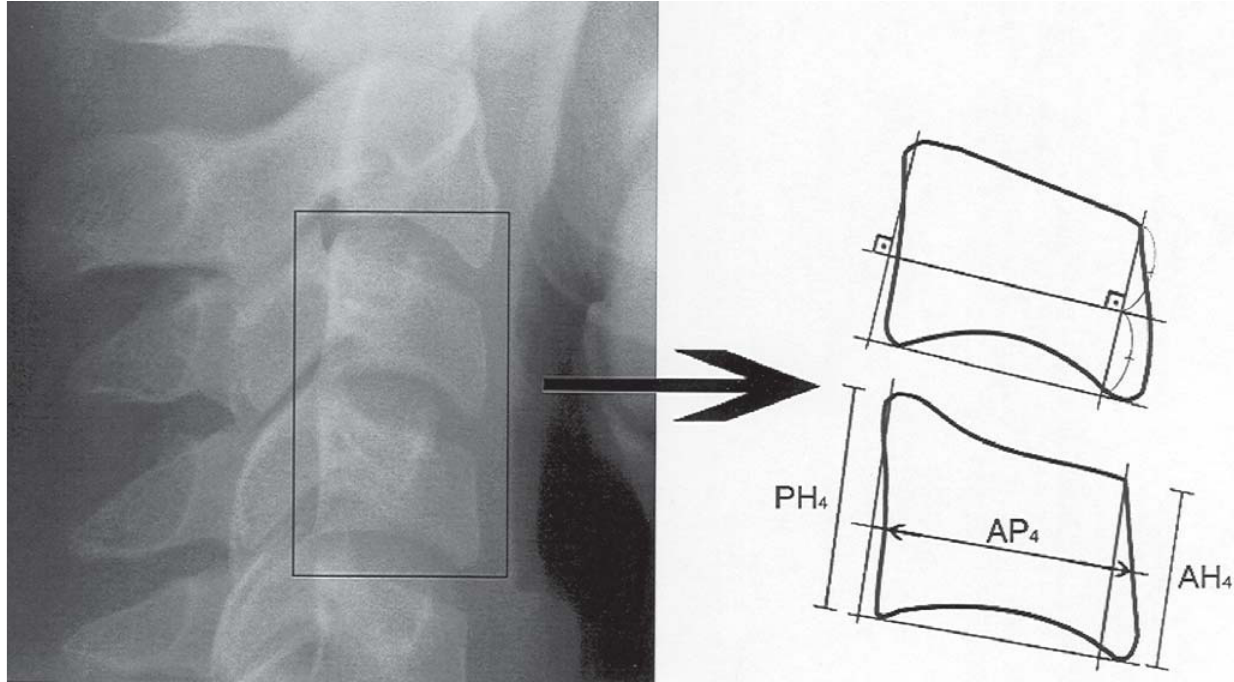
FIGURE 1- Areas of cervical vertebral bodies measured on cephalometric radiographs: AH front part to the tangent of the lower part; PH anteroposterior distance at the middle of the cervical vertebral body